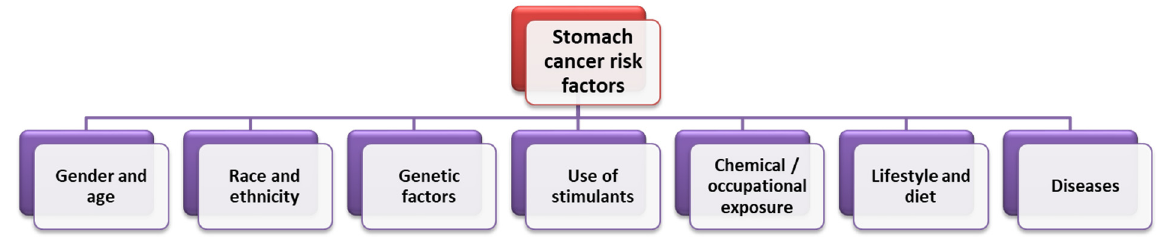
Figure 3. Factors influencing the incidence of GC (based on [24]).